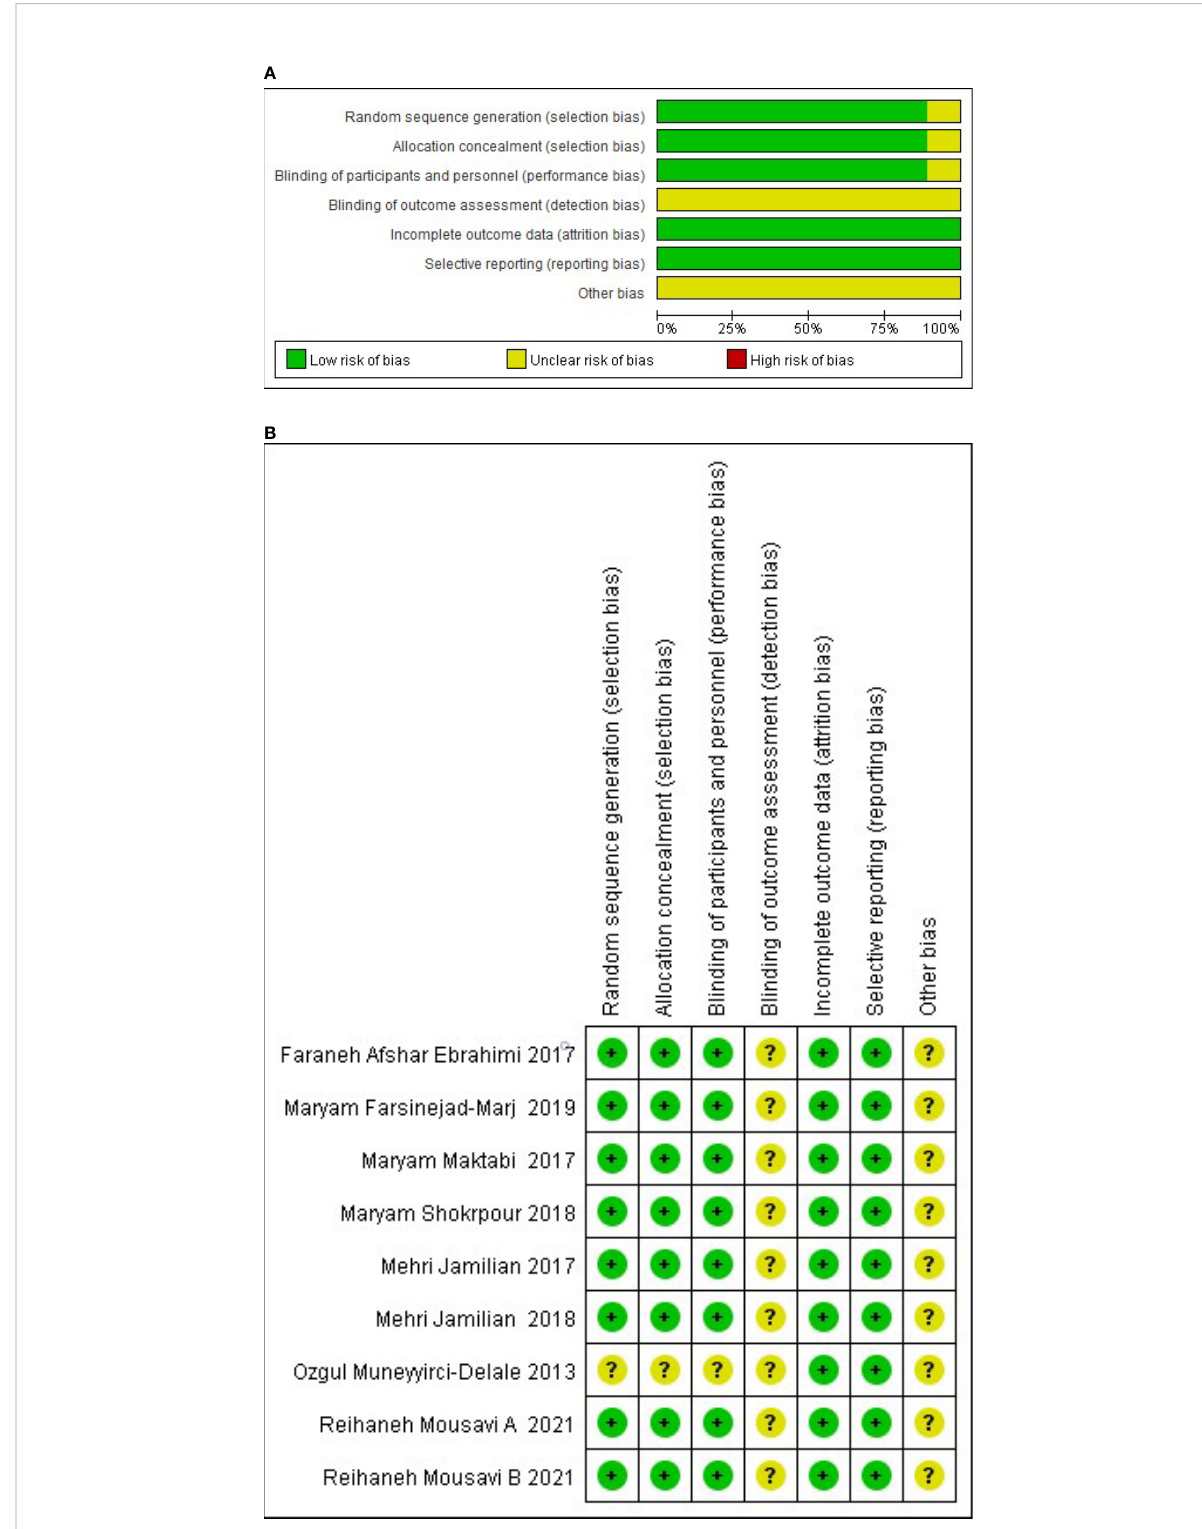
FIGURE 2 (A) Graph showing the risk of bias, (B) Summary of the risk of